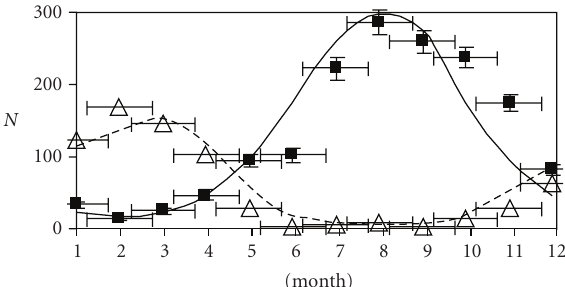
Figure 4: Number of storms predicted per month of the year during the period 1960–2006 versus numbers actually observed for the North Asia basin (filled circles) and the Asian Southern Hemisphere (open triangles). The model predictions (continuous curve) have been smoothed and have been normalized to the